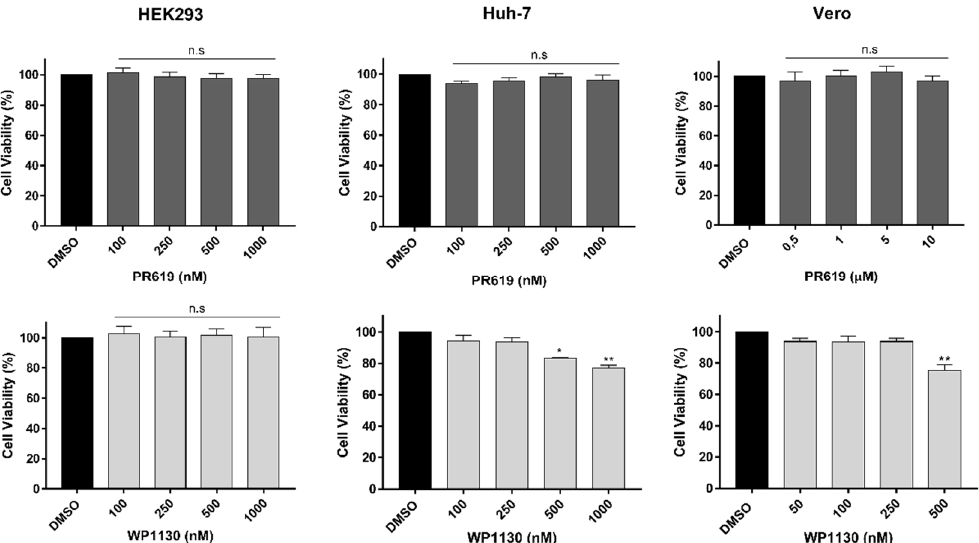
Figure 1. Cytotoxic effect of deubiquitinating enzyme inhibitors. HEK293, Huh-7, and Vero cells were exposed to PR-619 or WP1130 at the indicated concentrations, DMSO 0.1% was used as a control. After 24 h of treatment, cell viability was analyzed using the resazurin assay method. Data are represented as the mean + SD, and statistically significant differences are indicated as * p < 0.05, ** p < 0.01. n.s no significant differences.